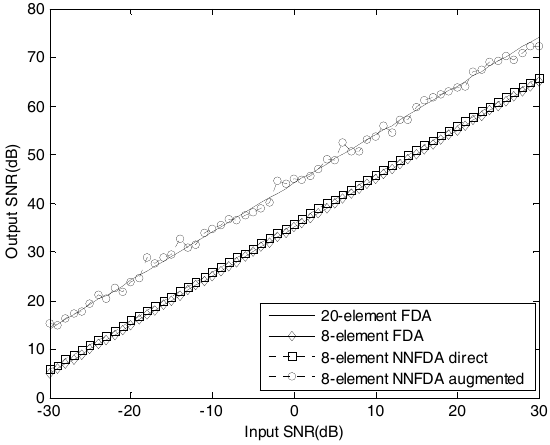
Figure 7. Output SINR versus input SINR.